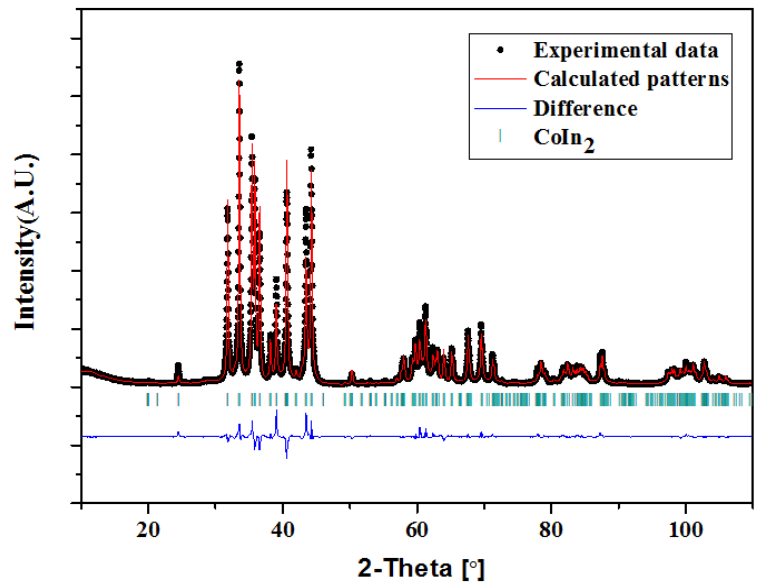
Figure 16. Observed, calculated and differential XRD patterns of Co 1 − x Ni x In 2 (x = 0.540).